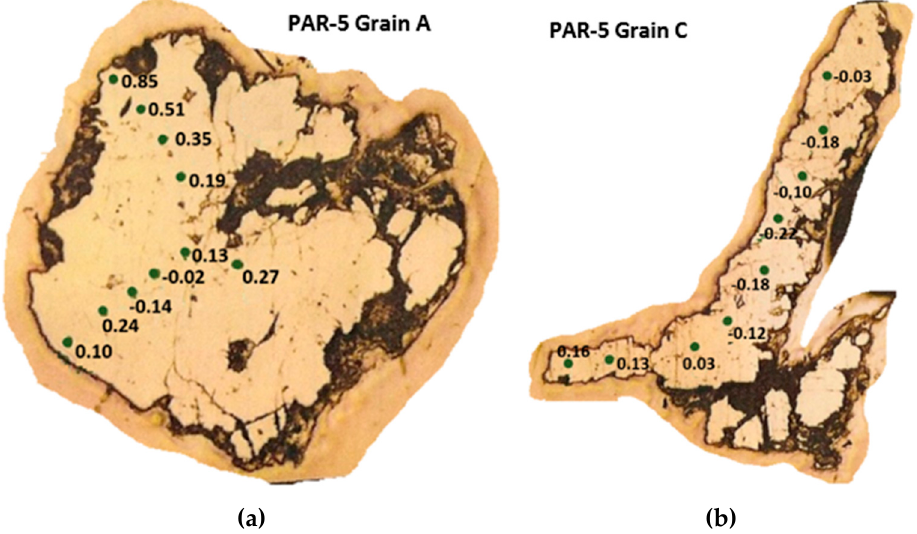
Figure 5. ( a ) SIMS in-situ analysis spot location individually marked on the ruby grain–PAR-5 Grain A; ( b ) SIMS in-situ analysis spot location individually marked on the ruby grain–PAR-5 Grain C.